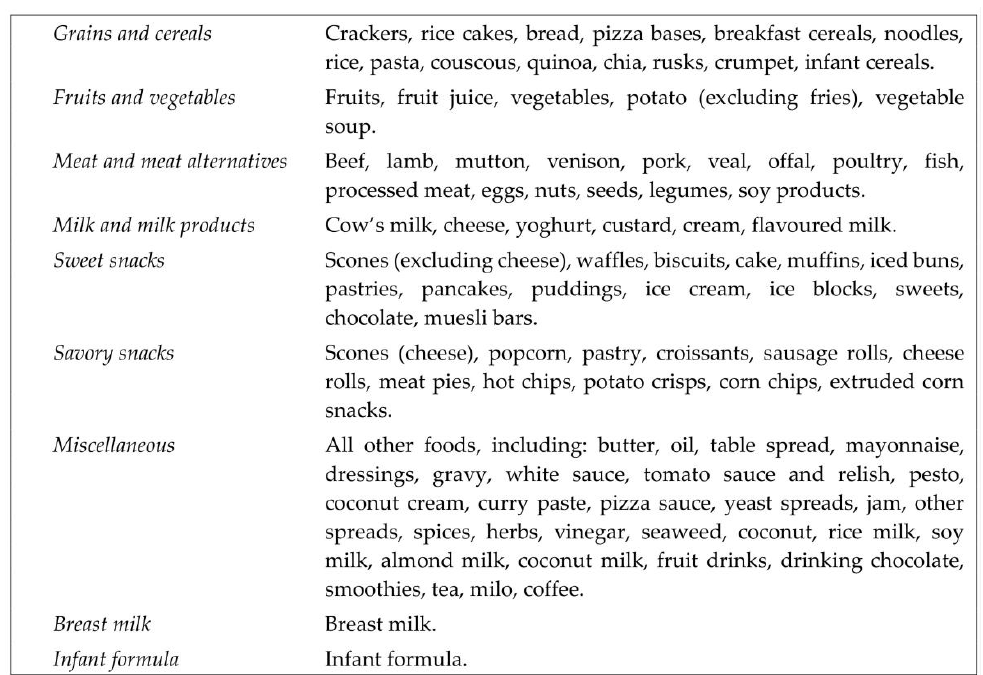
Figure 2. Descriptions of the nine food groups to which foods were assigned.